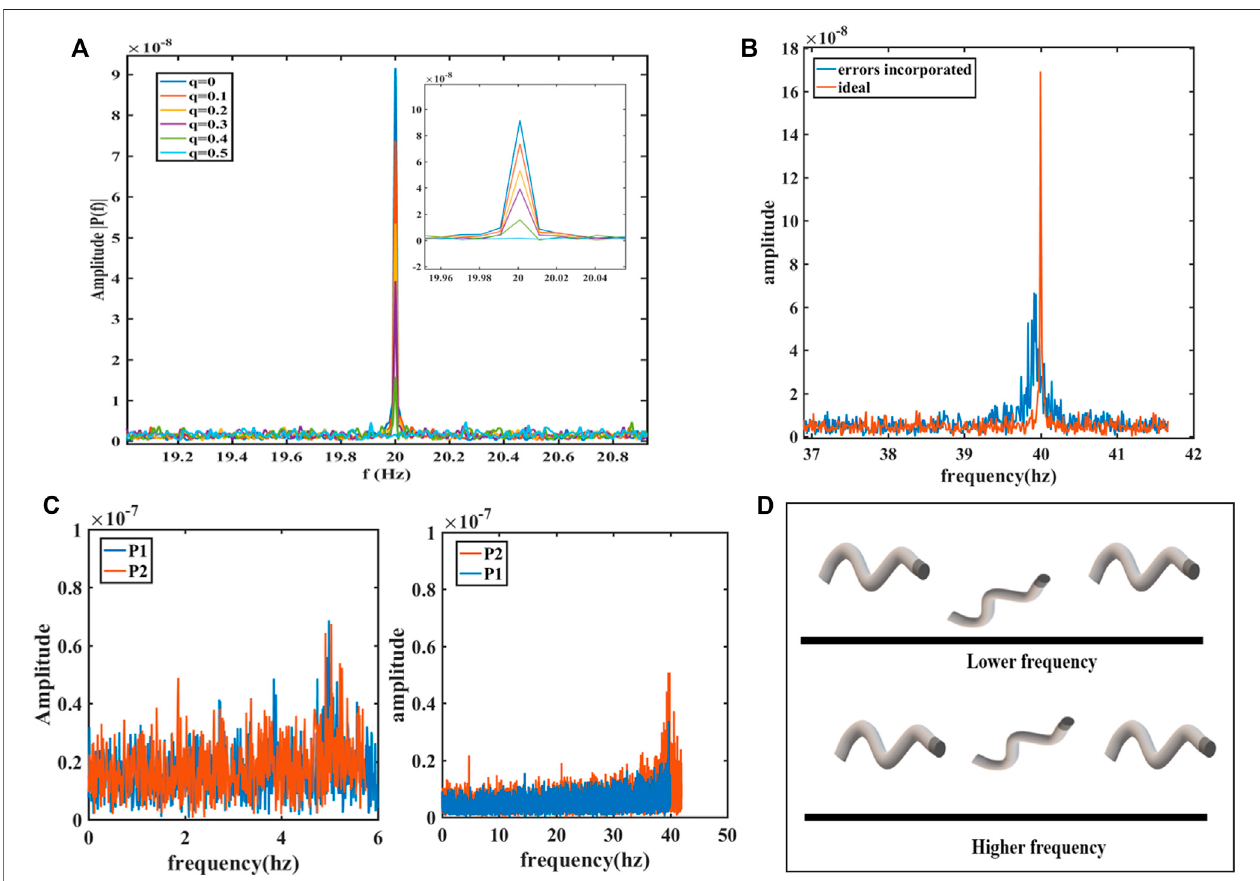
FIGURE 4 | (A) . The simulation where the Fourier space is plotted for different ‘ q ’ values. It shows a prominent peak at the actuating frequency and variation of Fourier amplitude and width of the peak as a function of ‘ q ’ . (B) . The simulated Fourier space is plotted (red) for an actuation frequency of 40hz and q (cid:1) 0.2. The other curve (blue) indicates the same curve but incorporating errors arising due to video capture. Though the peak widens, the area under both the curves remains the same. (C) .ComparingtheP1andP2swimmersatalowerfrequency(5hz)andhigherfrequency(40hz). (D) .Thesurfacemediatedeffectsmightin fl uencethedynamicsat lower and higher frequency of actuation. There is a possibility that at higher frequencies, the propeller might not have enough time to ‘ see ’ the